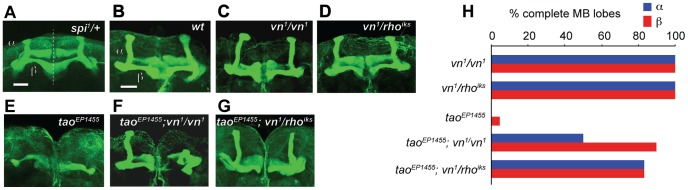
EGFR pathway mutations affect mushroom body development.(A) Anti-Fas II staining of wholemount brain from spi1/+. Dashed line represents the midline. Scale bar = 10 µm. (B–H) Suppression of taoEP1455 MB lobe morphology phenotype by mutations in vn and rho. Scale bar = 10 µm. (B) wt, (C) vn1/vn1 and (D) vn1/rhoiks brains have normal MB lobes. (E) taoEP1455 lacks MB α and β lobes. MB lobes in brains of (F) taoEP1455;vn1/vn1 and (G) taoEP1455;vn1/rhoiks flies. (H) Quantification of the proportion of normal MB lobes for genotypes in (C–G).